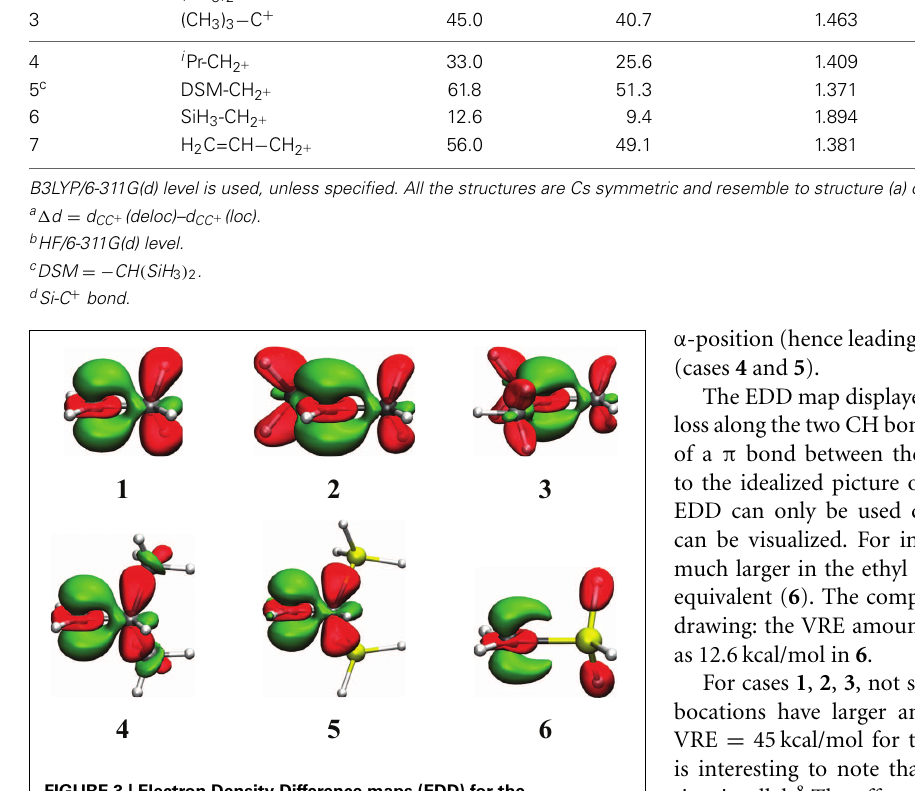
FIGURE 3 | Electron Density Difference maps (EDD) for the hyperconjugated carbocations reported in Table 2. In green is the electron gain, and in translucent red is the electron loss. An isodensity of 4 · 10 − 3 was used throughout. from the CH bonds to the C + atom amounts to 0.27 electron.